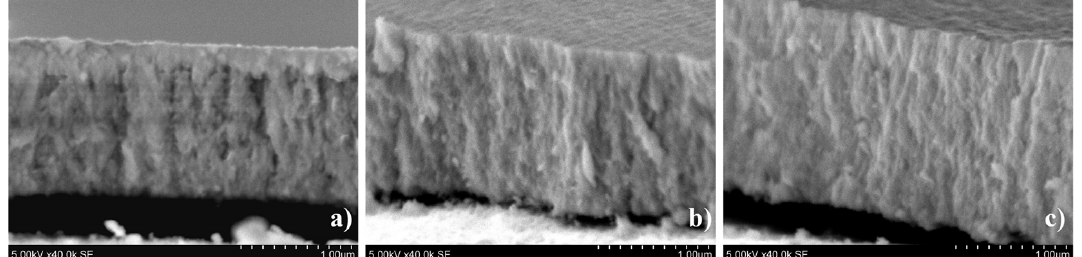
Figure 6. Cross-section images of ScAlSZ thin films deposited on 450 °C substrates using different deposition rates: ( a ) 0.4 nm/s, ( b ) 0.8 nm/s, and ( c ) 1.2 nm/s.